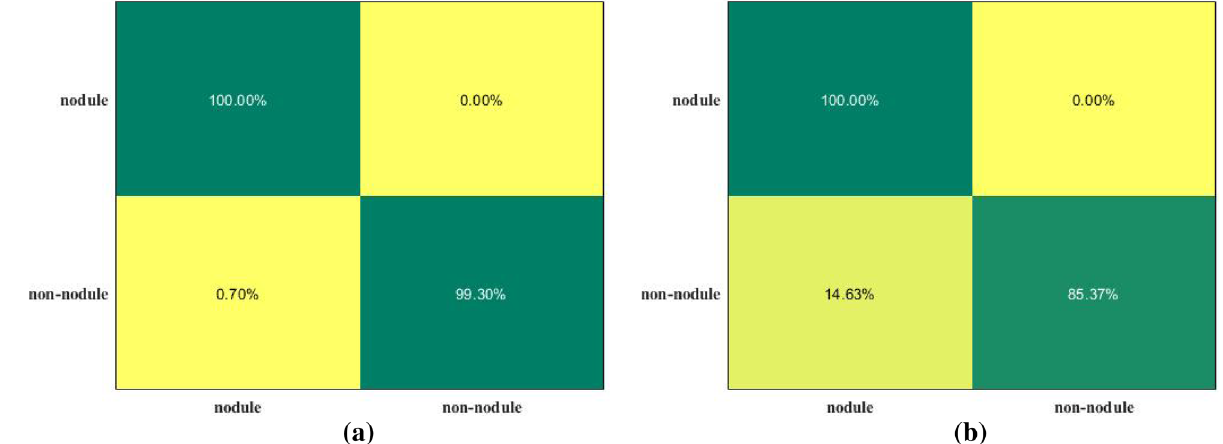
Figure 9. The confusion matrix of the proposed lung CAD